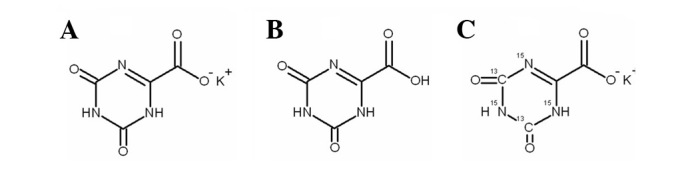
Chemical structures of (A) Oxo, (B) oxonic acid and (C) [13C2,15N3]-Oxo. Oxo, potassium oxonate.